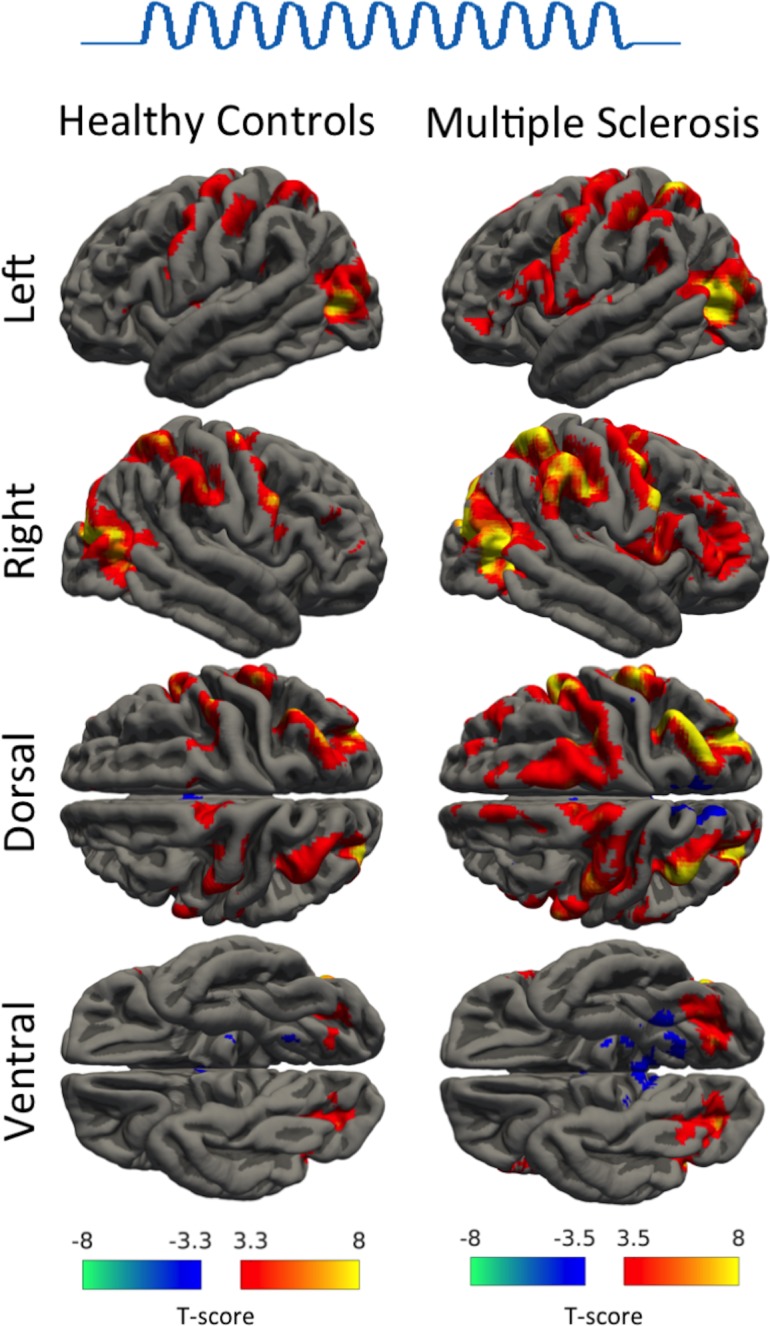
Main effect of the precision grip task.T-score maps showing the brain activation during the tonic precision grip task in healthy controls and patients with MS. For visualisation purposes, the maps were thresholded at an uncorrected p-value of < 0.001.